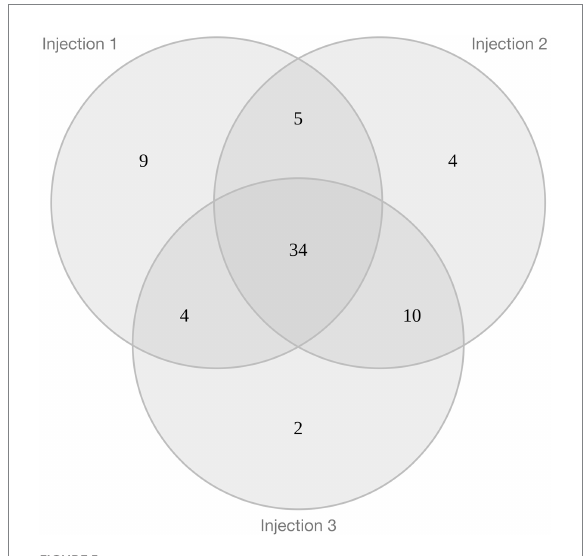
FIGURE 5 Venn diagram of the 68 proteins quantified by iTRAQ ® with triple injection which exhibit significative differential expression in brine extracts compared to liquid stationary culture